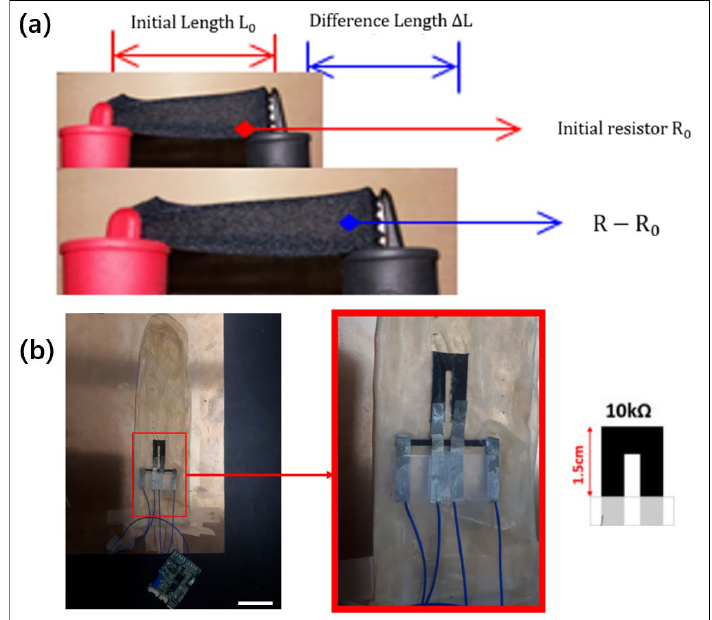
Figure 15. ( a ) A film that detects strain. ( b ) A combination of strain sensors that detects changes in penis length and diameter [210]. Reproduced under the terms of the CC-BY Creative Commons Attribution License, Copyright 2021 by the authors, published by